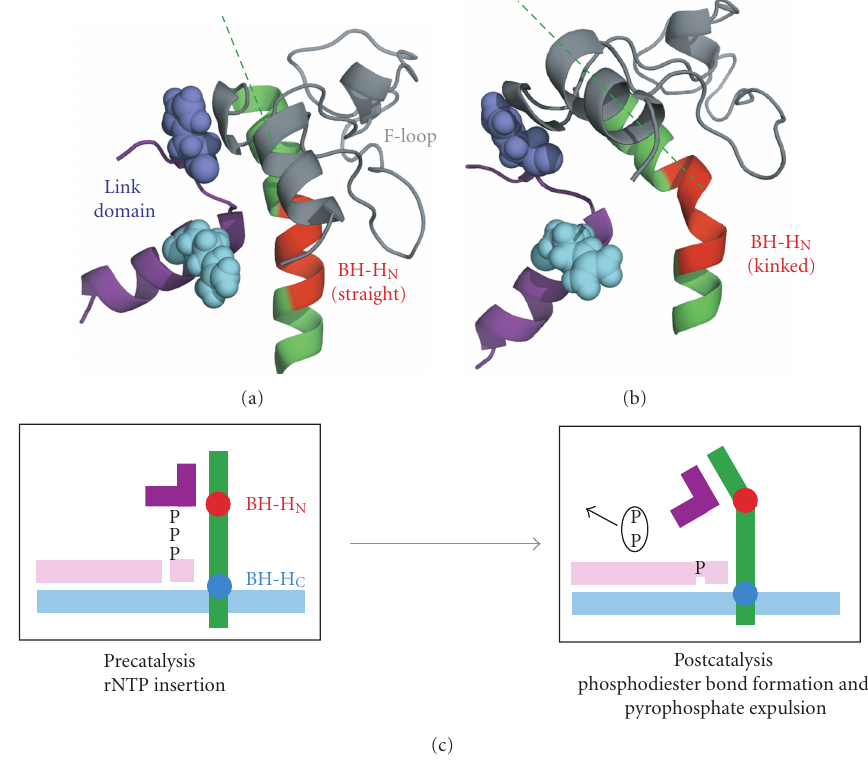
Figure 3: Structural connectivity between the F-Loop, Bridge Helix, and Link domain. (a) Structure of the complex at the begin of the simulation. The coloring scheme is as described in Figure 2(a). An additional residue, sc RPB2 H761, making close contact to the F-Loop is shown in space-filling mode in dark blue. The Bridge Helix N-terminus is fully α -helical and essentially straight. (b) During the molecular dynamics simulation, a kink in BH-HN (red section of the Bridge Helix) occurs and tilts the F-Loop and associated Link domain towards the left. (c) Interpretation of the e ff ects of the structural changes observed in (a) and (b) on the nucleotide insertion site. The removal of the pyrophosphate group after successful incorporation of the nucleotide into the nascent transcript removes a structurally stabilizing contact and may thus influence the spatial position and conformation of the Link